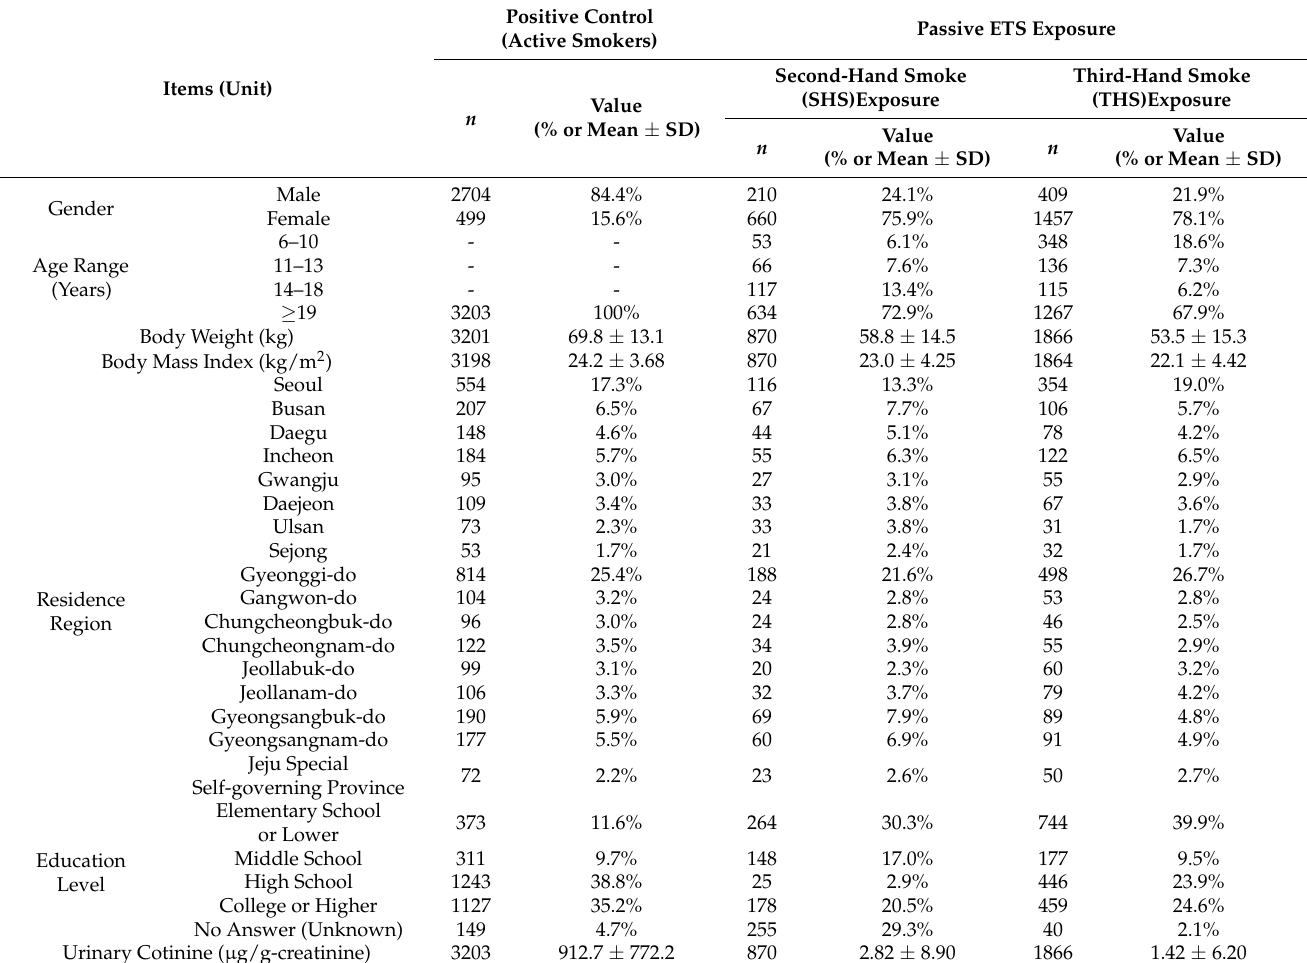
Table 2. Socio-demographic information and urinary cotinine level of the